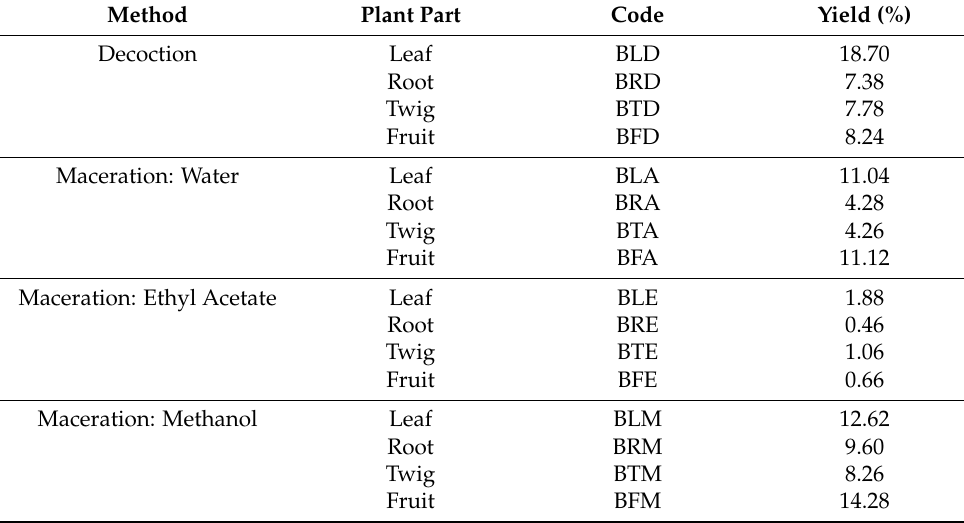
Table 1. Yield and code with respect to extract